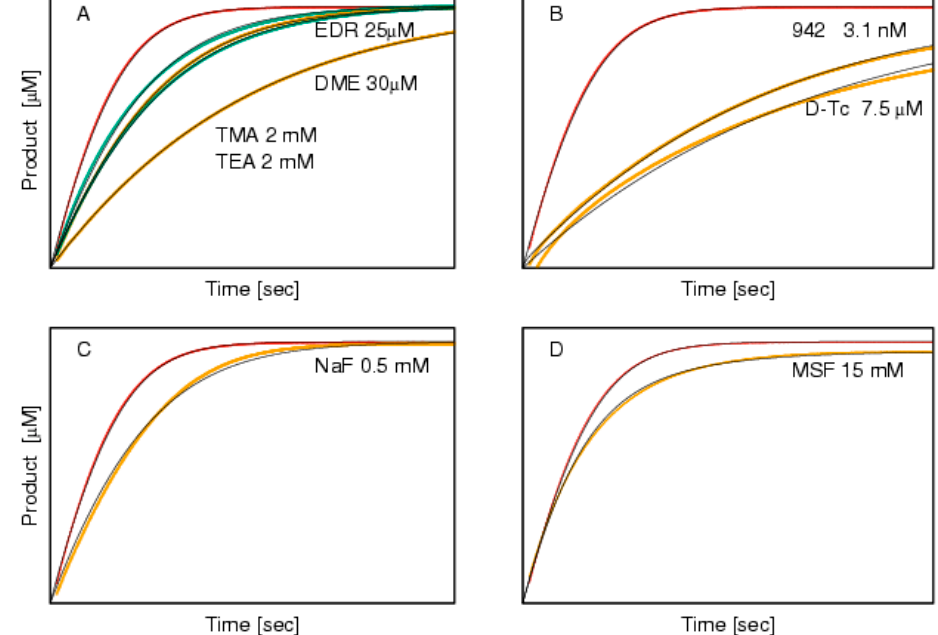
Figure 1. Progress curves (to 600 s) for the hydrolysis of 50 µ M BSCh in the absence (red curves, in all panels) and presence of the eight inhibitors. ( A ) The reversible competitive inhibitors tetramethylammonium (TMA, upper green), tetraethylammonium (TEA, lower green) edrophonium (EDR, upper orange), and decamethonium (DME, lower orange); ( B ) The slow binder d -tubocurarine (D-Tc, lower orange) and the tight binder 942 (upper orange); ( C ) The mixed reversible inhibitor sodium fluoride (NaF); ( D ) The irreversible inhibitor methanesulfonylfluoride (MSF). The action of the small irreversible inhibitor, methanesulfonylfluoride (MSF), is shown